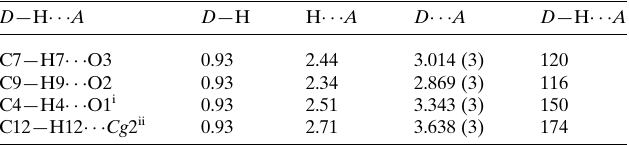
Table 1 Hydrogen-bond geometry (A˚ , (cid:2) ). Cg 2 is the centroid of the C3–C8 ring.